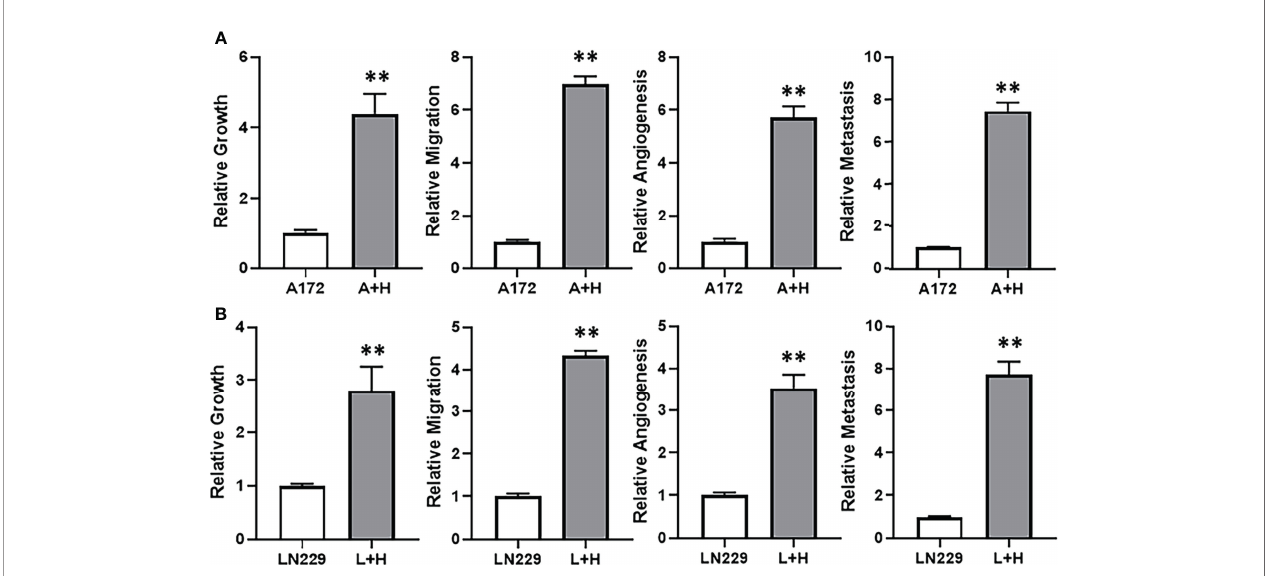
FIGURE 3 | HOTTIP impacts cellular proliferation, migration and markers of angiogenesis and metastasis. A172 (A) and LN229 (B) cells were transfected with lncRNA HOTTIP and cell growth (by MTT), migration, angiogenesis (VEGF secretion by ELISA) and metastasis (MMP-9 secretion by ELISA) were measured. A+H: A172 cells with HOTTIP, L+H:LN229 cells with HOTTIP. **p <